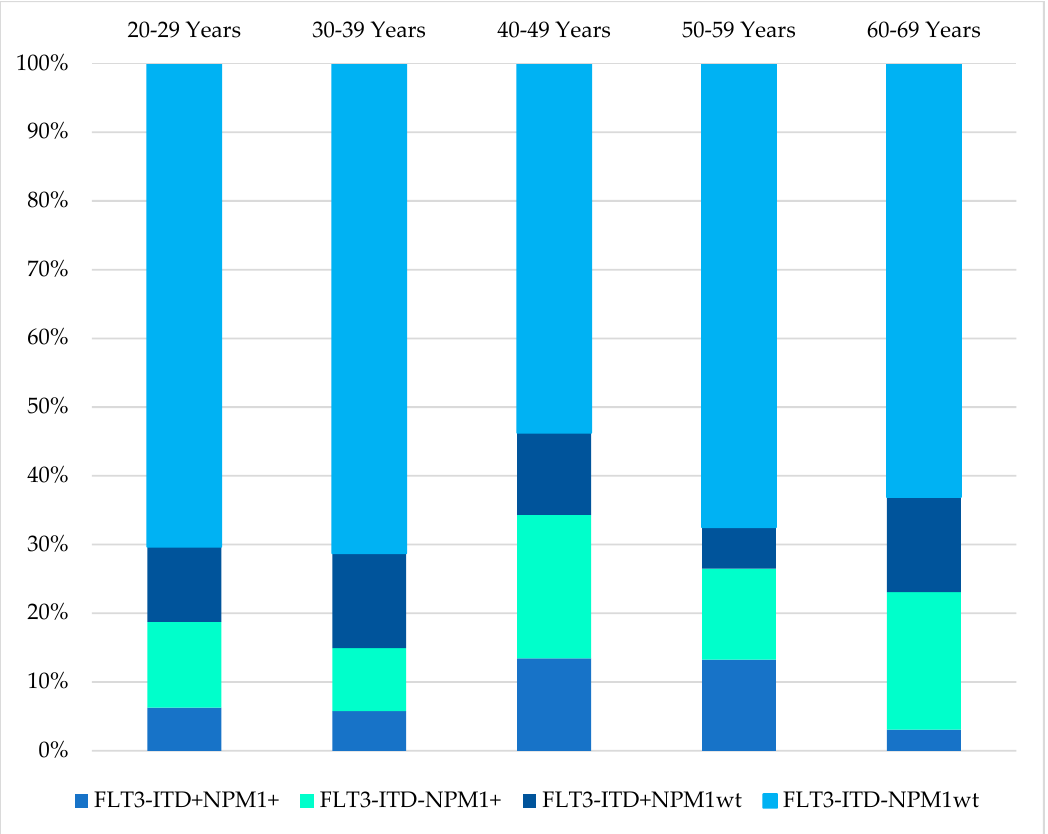
Figure 6. Age distributions of AML patients by their FLT3-ITD/NPM1 mutation status.